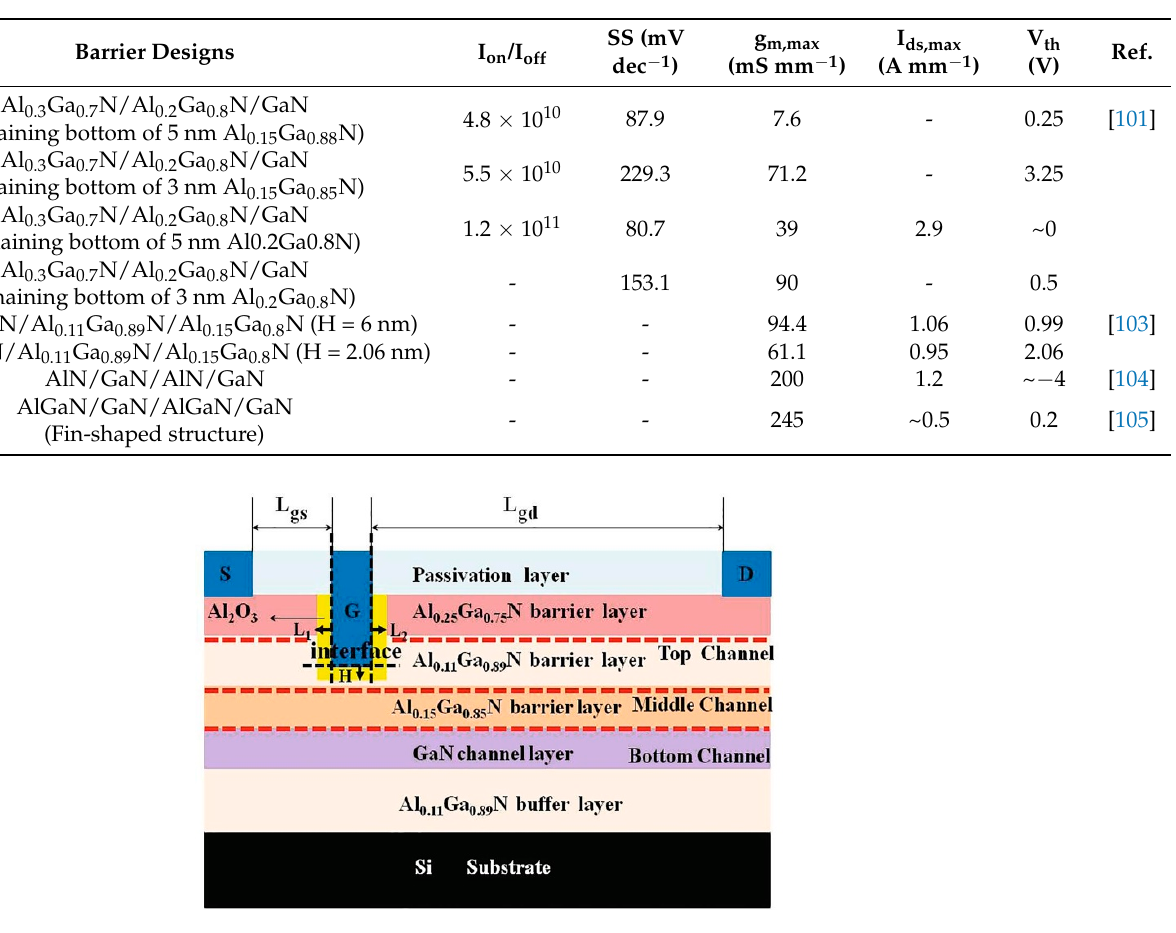
Figure 5. ( a ) Schematic device structure with L GS /L G /L GD /W G = 2/4/10/100 µm and ( b ) transmission electron microscopy (TEM) image of the device. Reprinted with permission from ref. [97]. Copyright 2021 MDPI. Table 3. Electrical characteristics of multiple-barrier GaN-based HEMTs, based on recent literature. The threshold voltage (V th ) varied greatly depending on the AlGaN barrier layers’ design and recessed-gated depth (H).